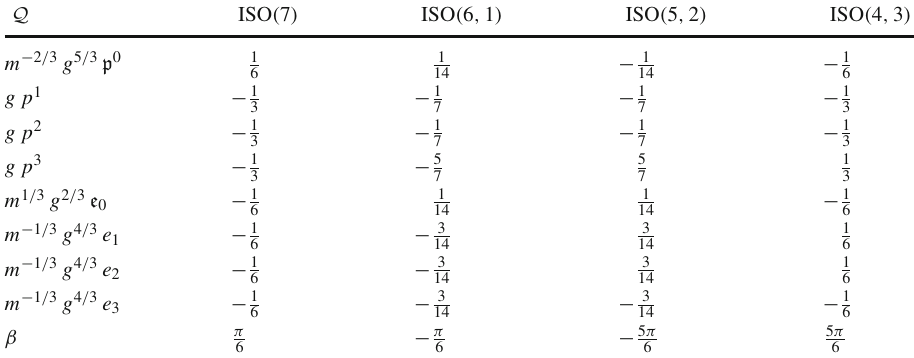
supporting supersymmetric AdS 2 × (cid:2) 2 solutions in the massive IIA